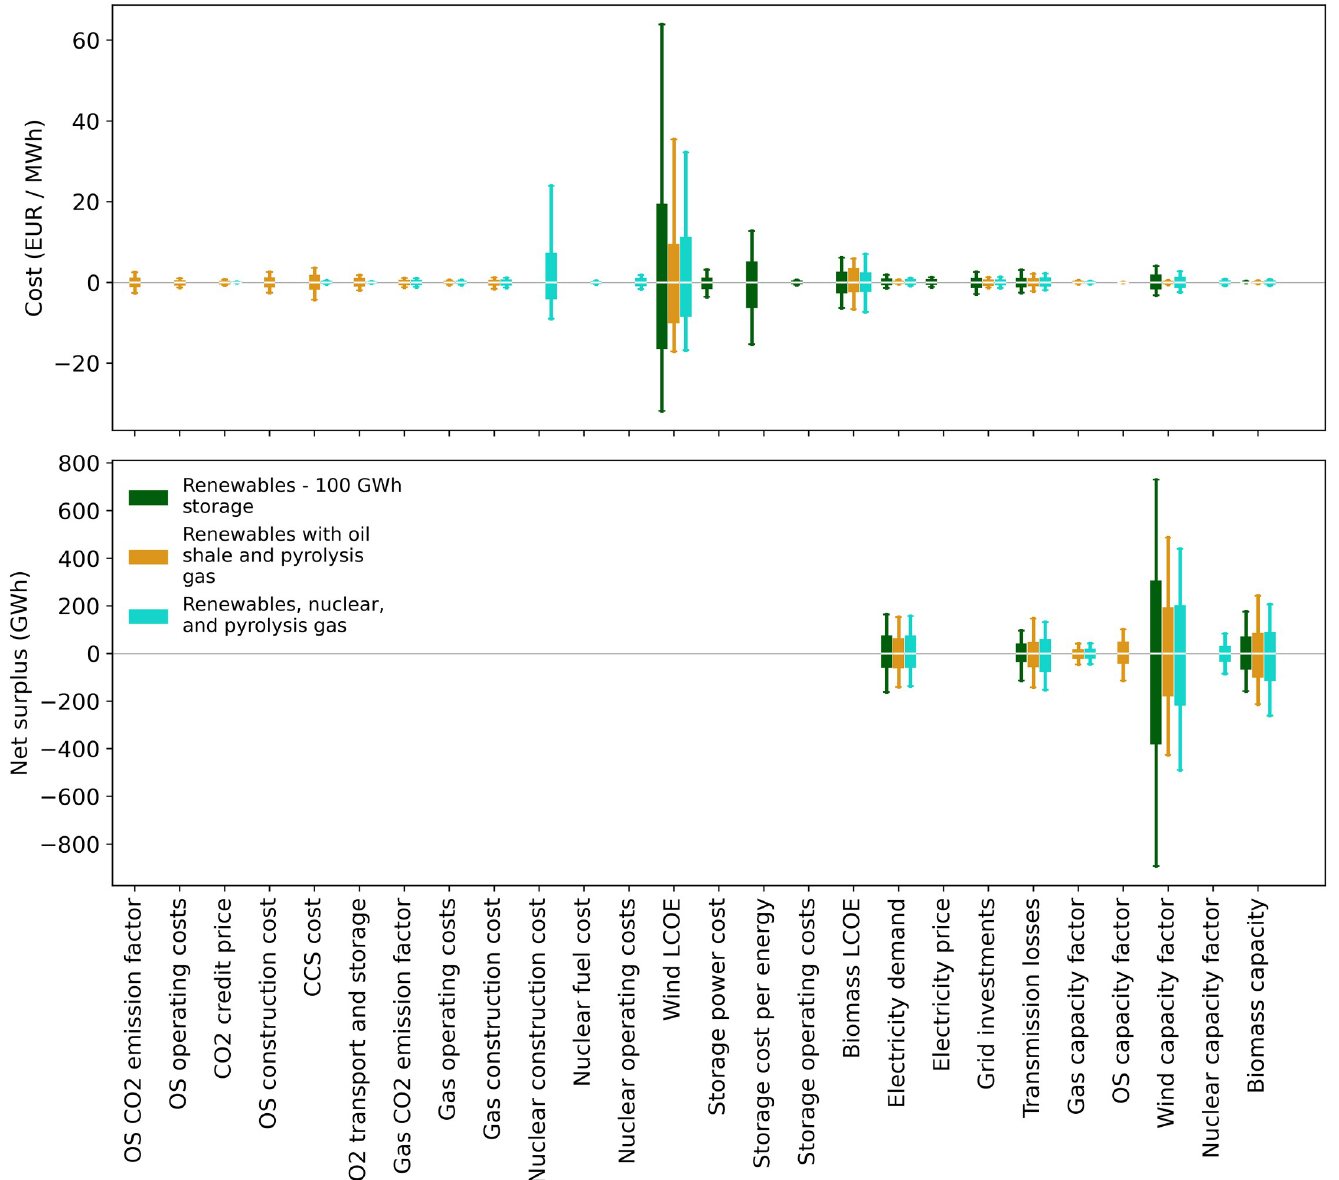
Fig 8. Sensitivity analysis showing how the variability of individual parameters impacts the cost and net surplus of the electricity grid.